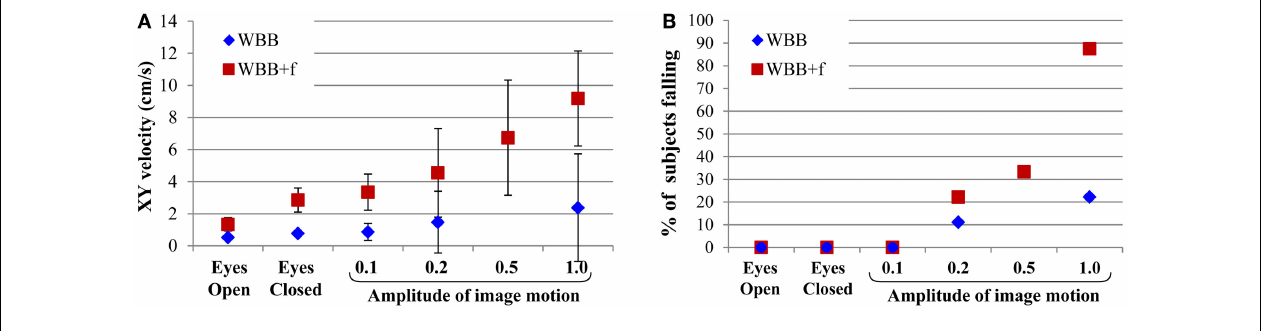
FIGURE 5 | (A) Velocity in XY of body center of gravity displacement for the visual conditions delivered (eyes open and closed, and virtual reality with amplitudes of 0.1, 0.2, 0.5, and 1.0). The error bars show the SD.